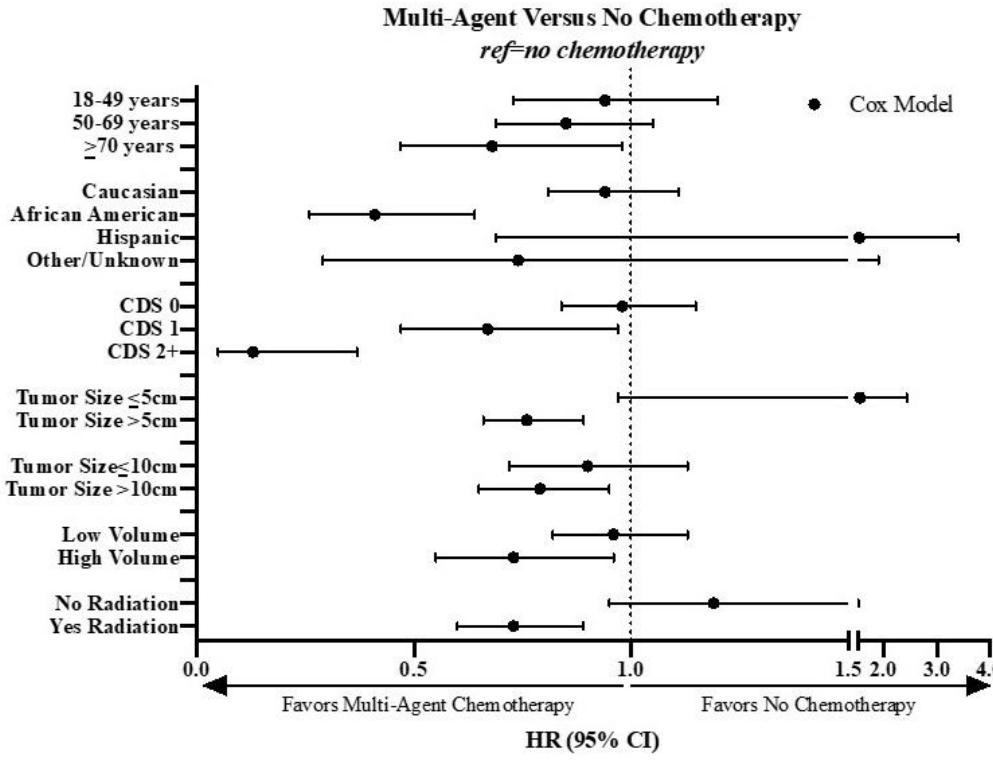
Figure 3. Cox proportional hazards model and PSM results of the subgroup analysis of the association between multi-agent chemotherapy and OS in patients with primary high-grade extremity and trunk STS in the NCDB from 2004 to 2016. CDS = Charlson–Deyo Score; CI = confidence interval; HR = hazard ratio; NCDB = National Cancer Database; OS = overall survival; PSM = propensity score matching; STS = soft tissue sarcoma.